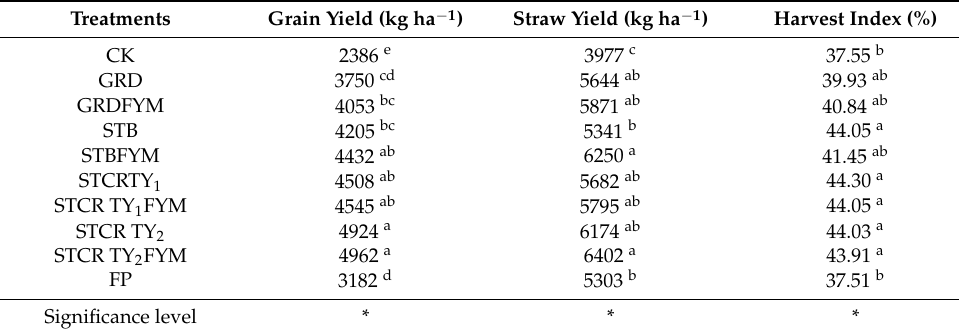
Table 7. Yield and harvest index of direct-seeded rice under different